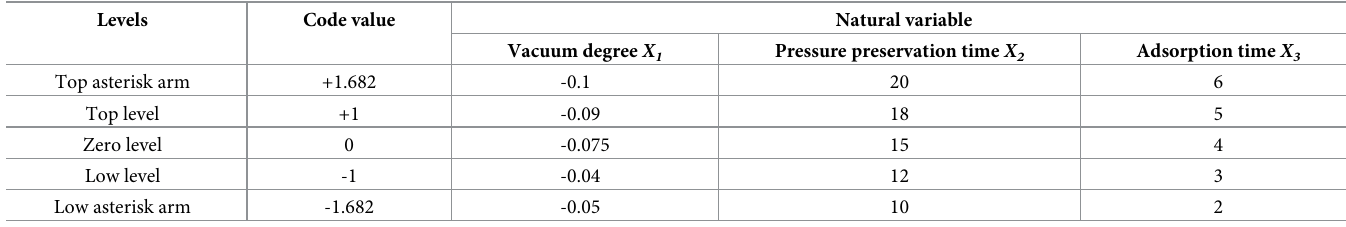
Table 2. Factor-level encoding